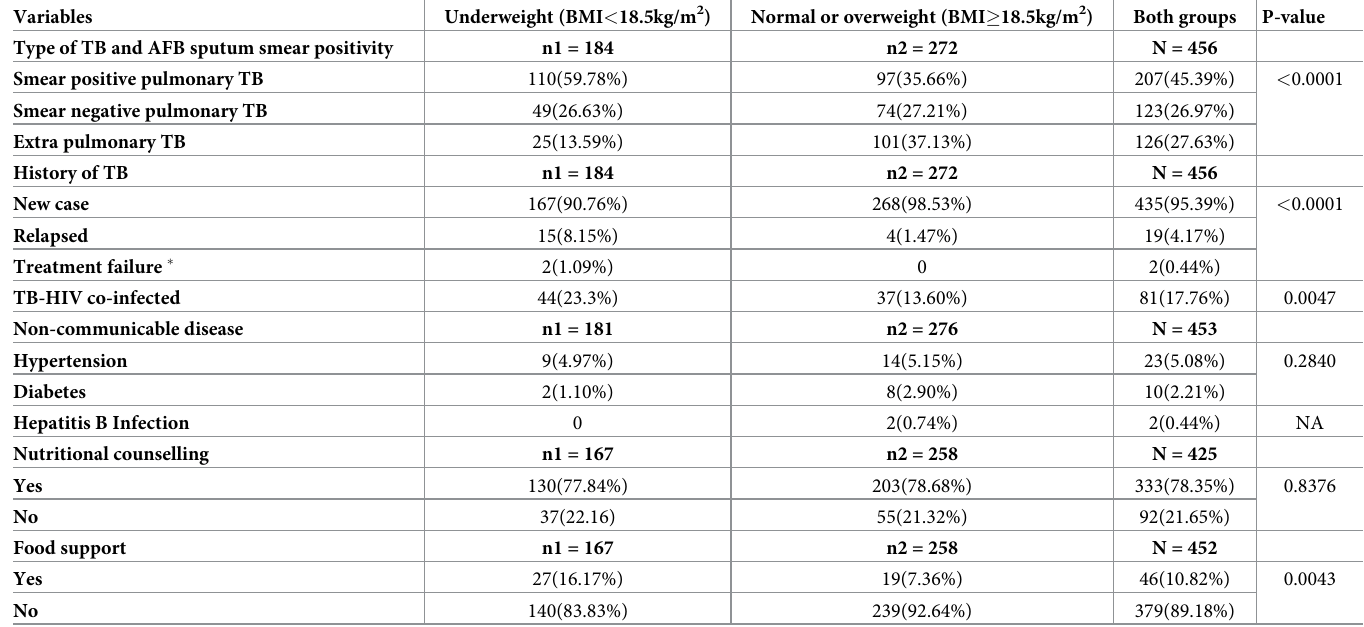
Table 2. Clinical characteristics and nutritional support of adult TB patients in public health centers of Addis Ababa, Ethiopia,